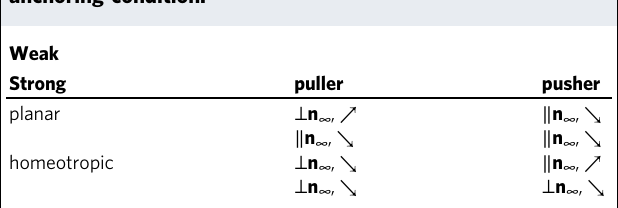
Table 1 The swimming stable direction of an elongated swimmer depending on its type (puller/pusher) and anchoring